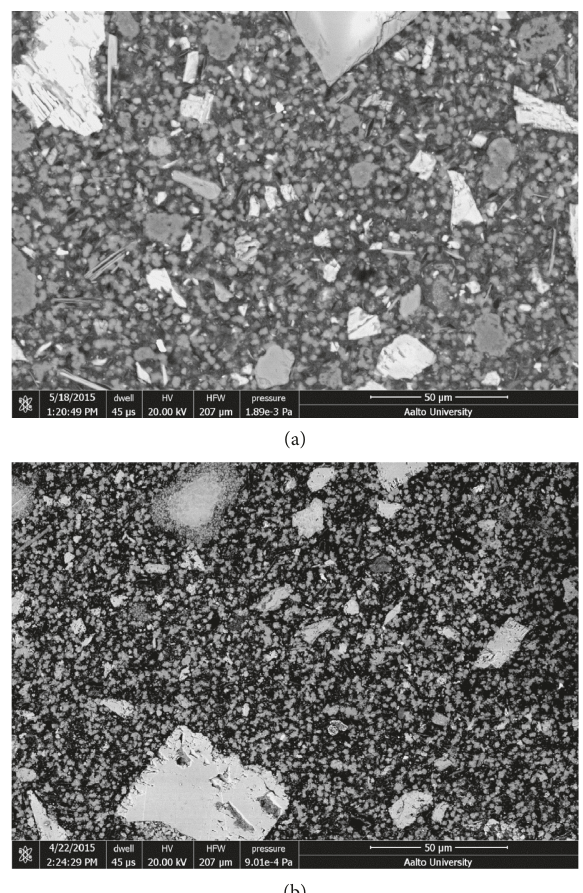
Figure 9: BSE-SEM images of 28-day old mixes: (a) MOHMgO and (b)